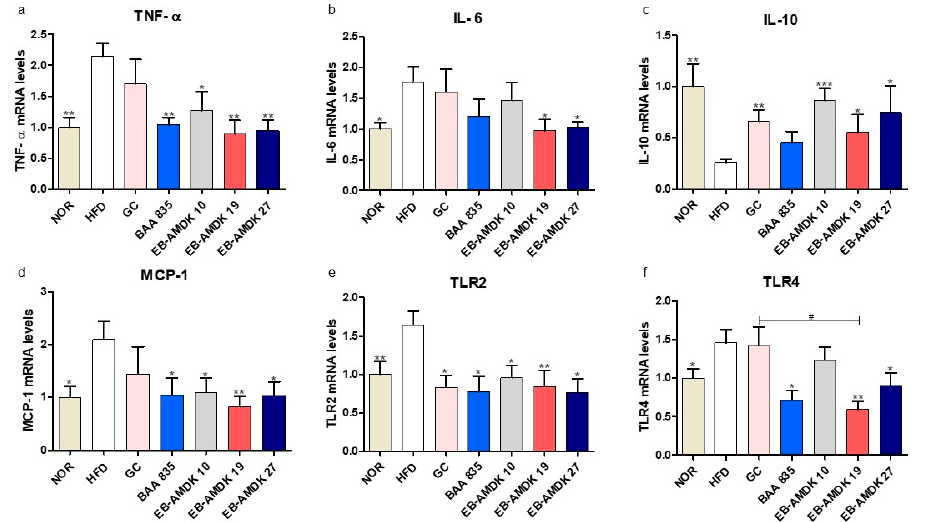
Figure 6. A. muciniphila treatment had anti-inflammatory effects on the colon of the HFD-fed mice. mRNA levels of inflammatory cytokines ( a ) TNF- α , ( b ) IL-6, ( c ) IL-10, ( d ) MCP-1, ( e ) TLR2 and ( f ) TLR4 in the intestine tissues of each group. The data are represented as the mean ± SEM. The data were analyzed with one-way ANOVA or Student’s t-test. * p < 0.05, ** p < 0.01 and *** p < 0.001 versus the HFD group. # p <